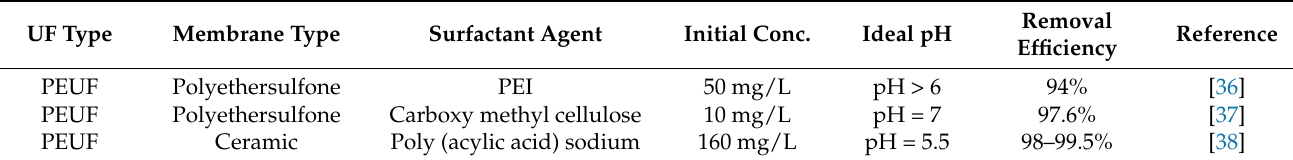
Table 1. Cu (II) removal by PEUF